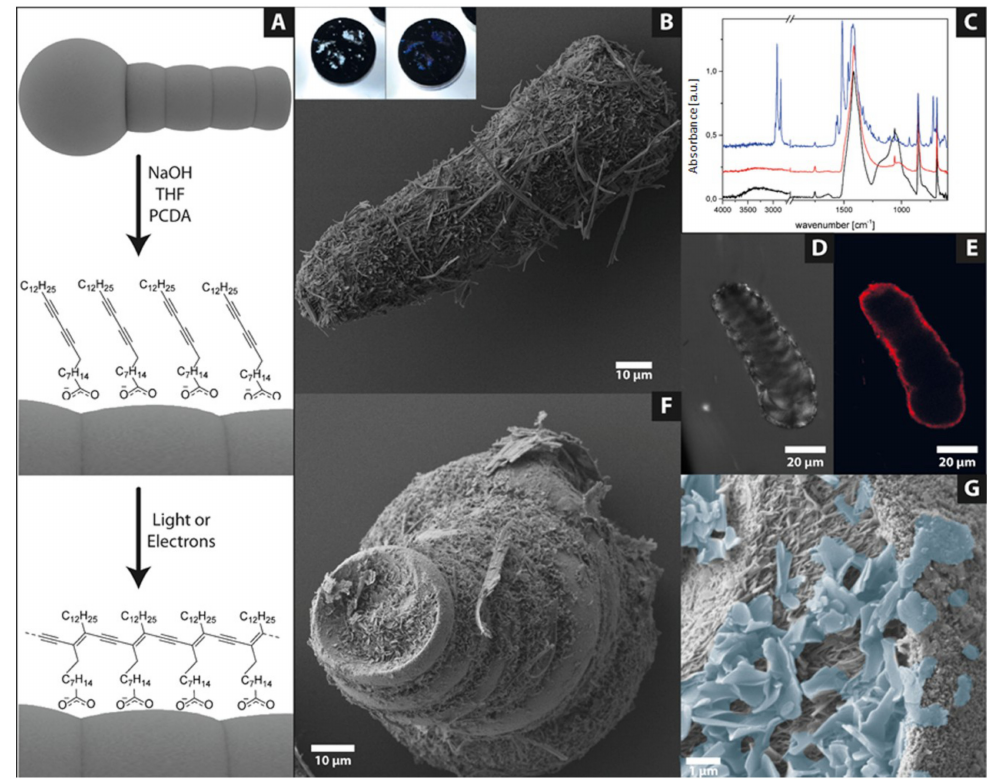
Figure 2. ( A ) Scheme of biomorph coverage with 10,12-pentacosadiynoic acid (PCDA) and the polymerization to pPCDA. ( B ) Scanning electron microscope (SEM) image of a fully covered biomorph worm (inlet: colour transformation of the powder after SEM investigation; c(PCDA) = 12,000 ppm). ( C ) Attenuated total reflection Fourier transformed infrared (ATR-FTIR) spectra of an untreated biomorph (black) a naked biomorph (red) and a pPCDA covered biomorph (blue). (D/E) Confocal Laser scanning microscopy (cLSM) images of a fully covered biomorph worm in the transmission ( D ) and fluorescence ( E ) channel. ( F ) SEM image of a partially covered biomorph worm (c(PCDA) = 2000 ppm) with the corresponding image at higher magnification ( G ), the blue coloured flakes indicate the